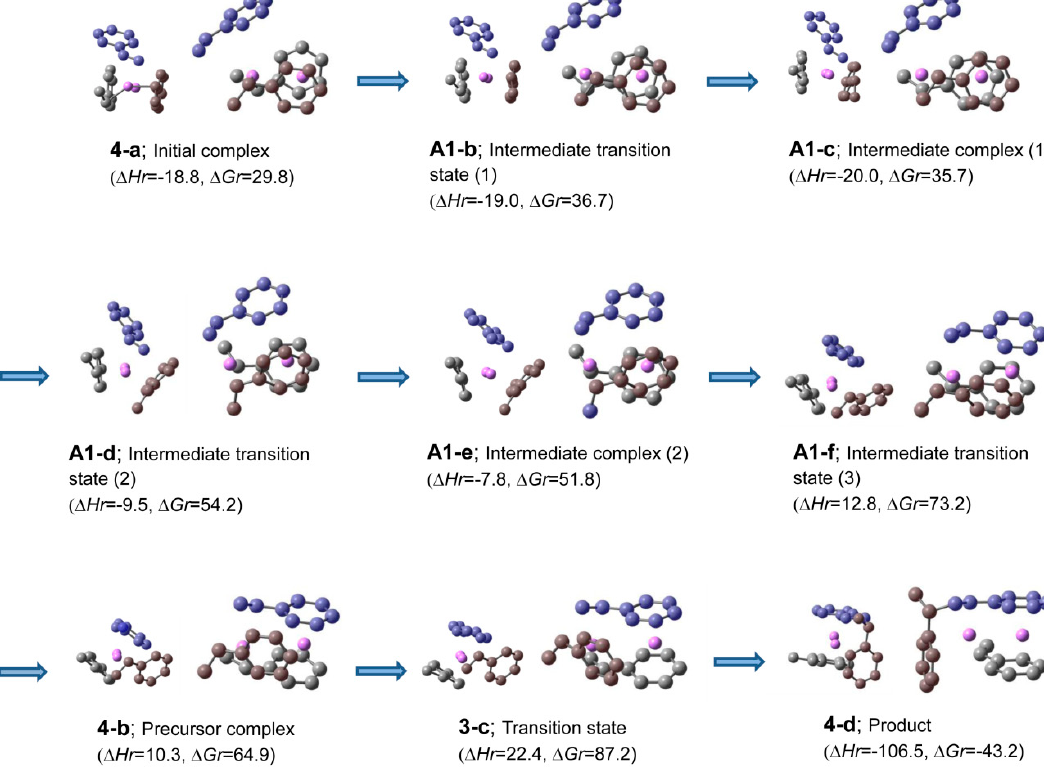
Figure A1. Complete reaction pathway for St/[(HStLi) 2 ( 1-c )] (system(dim-r)) in the gas phase, corresponding to Figure 4 and including all the drawings. The drawing details can be found in the description of Figure 4.